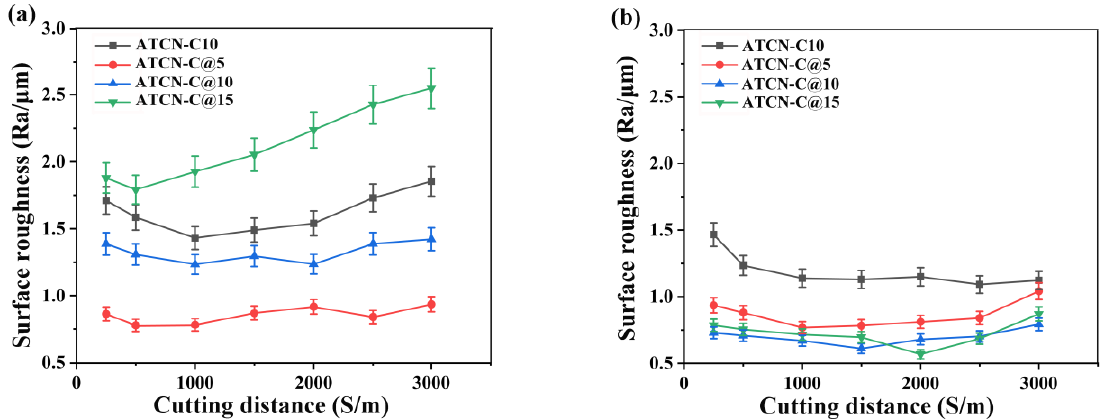
Figure 7. The surface roughness of four ceramic tools at cutting speeds of ( a ) 100 m / min and ( b ) 300 m / min (test conditions: depth of cut α p = 0.2 mm, feed rates 𝑓 = 0.102 mm/r).